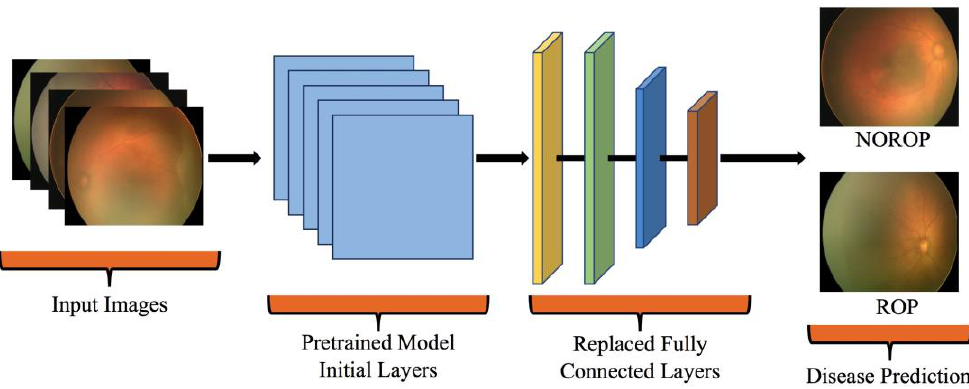
Figure 2. Graphical representation of transfer learning with pretrained models for disease prediction.